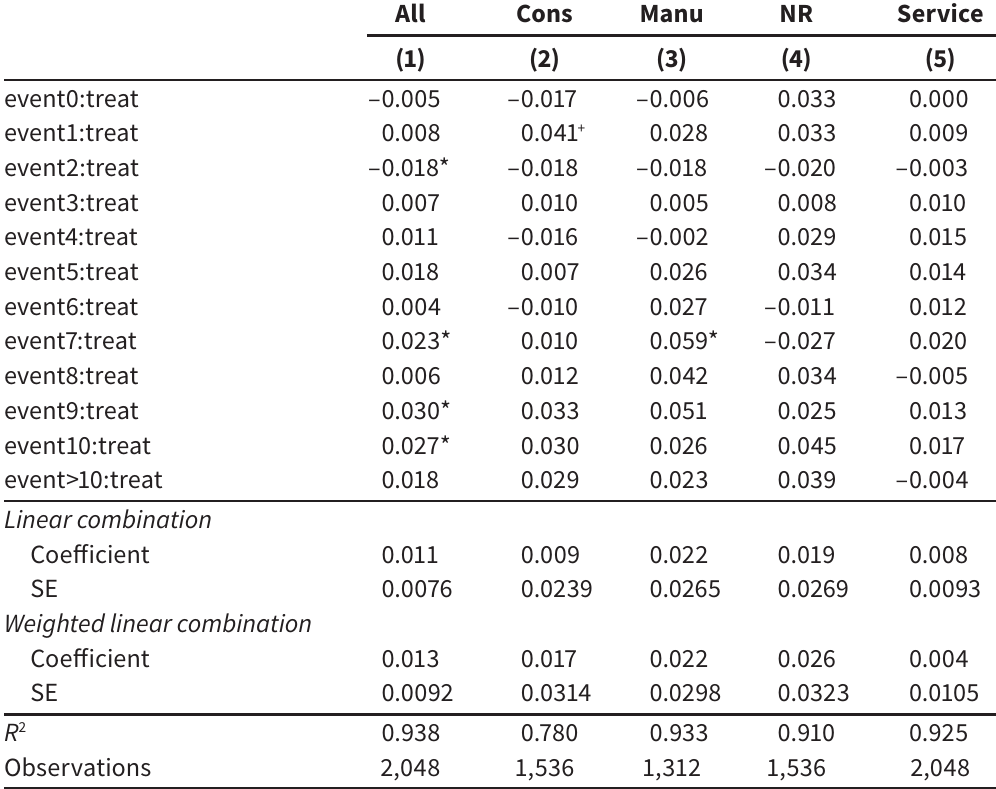
Table A5 Event study estimates post-dispensary entry periods for wages, by industry All Cons